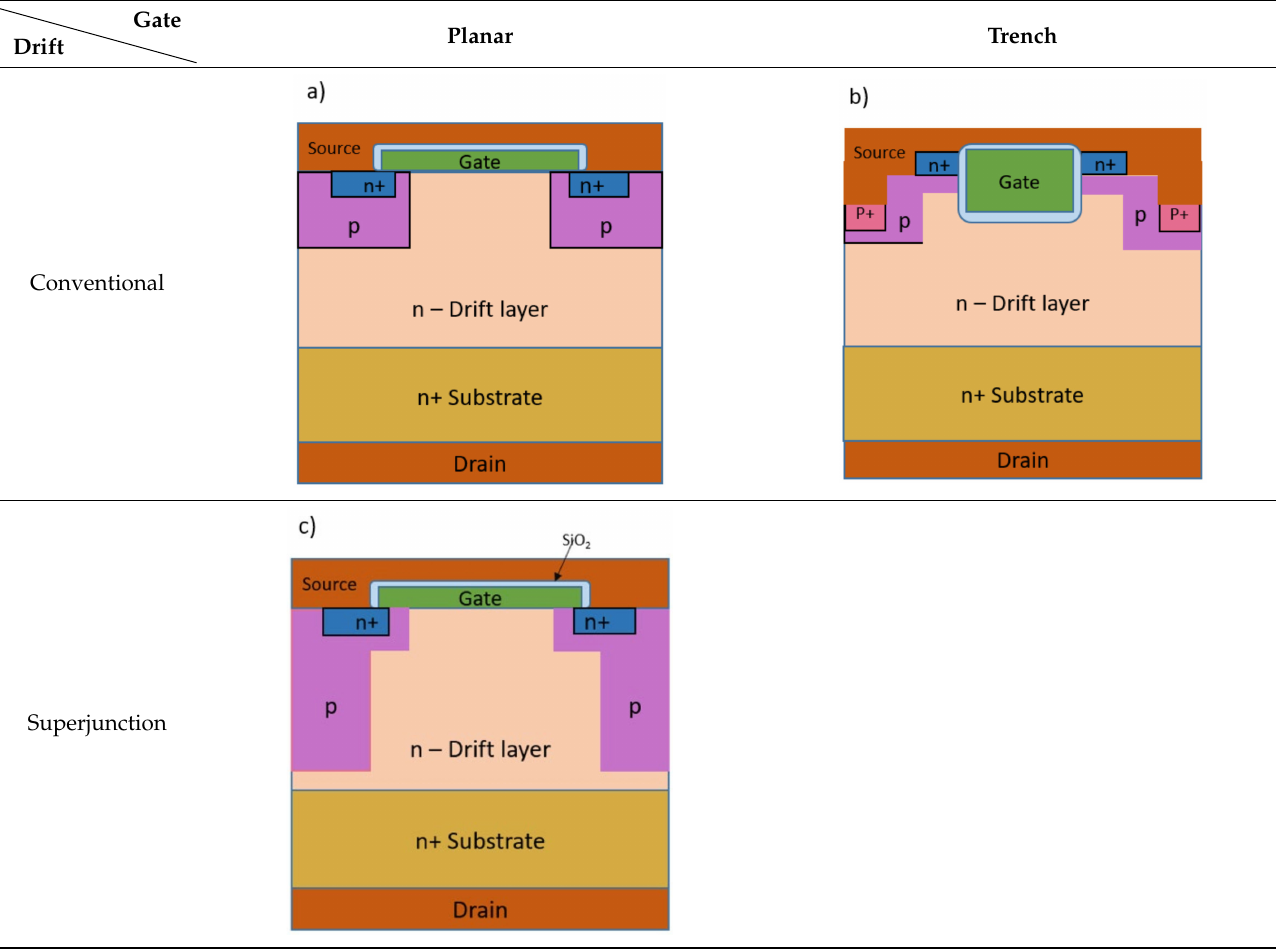
Table 3. Basic classification of SiC MOSFETs based on gate and drift